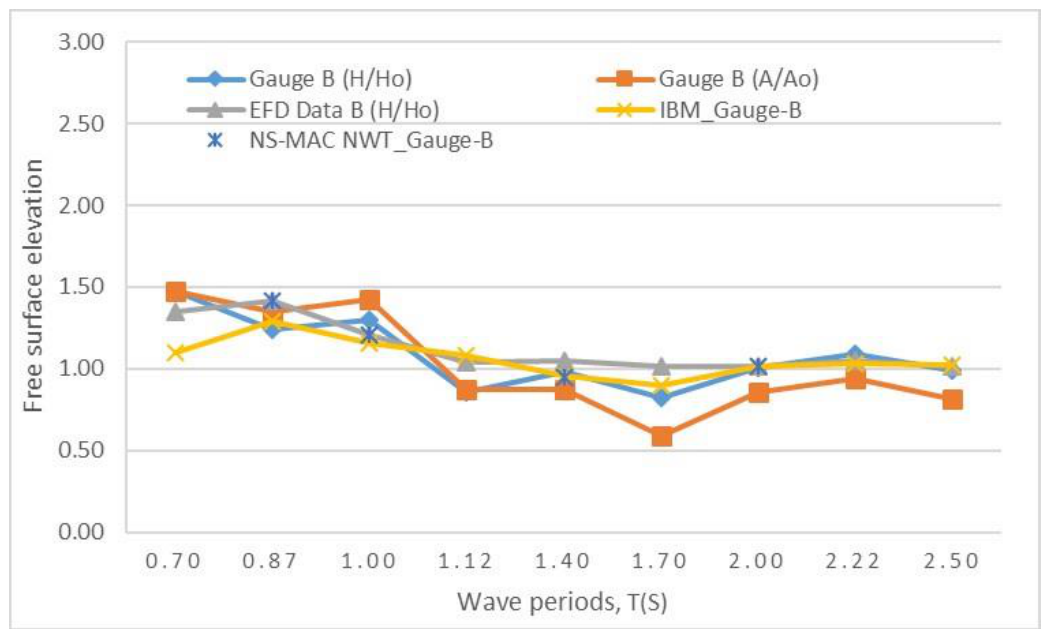
Figure 6. Comparison between CFD, experimental and numerical data of wave amplitude and heights for location B [5,25,26].